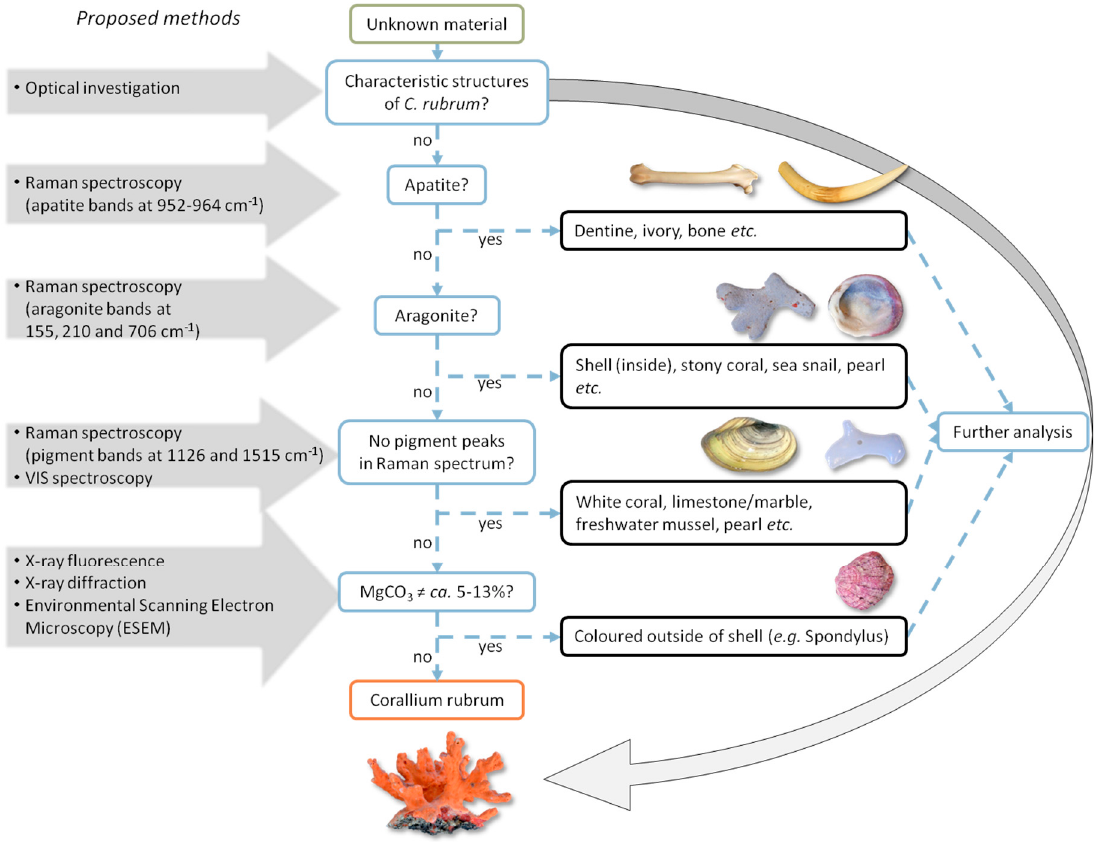
Figure 11. Protocol for non-invasive identification of Corallium rubrum . Figure 12. Protocol for non-invasive identification of Corallium rubrum